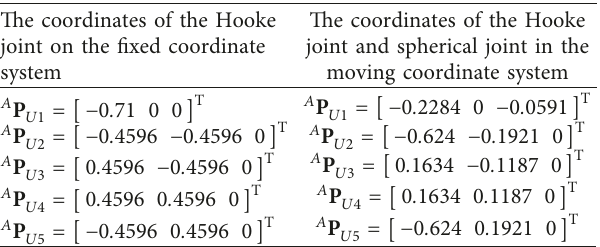
Table 2: The coordinates of joints on the fixed platform and moving platform (unit: